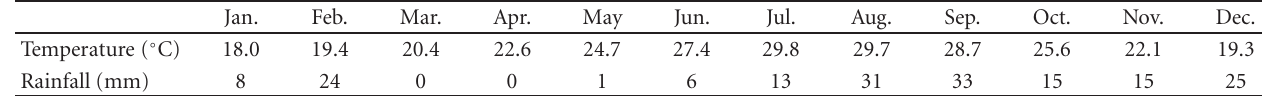
Table 1: Average monthly temperature and rainfall at La Paz, Mexico.